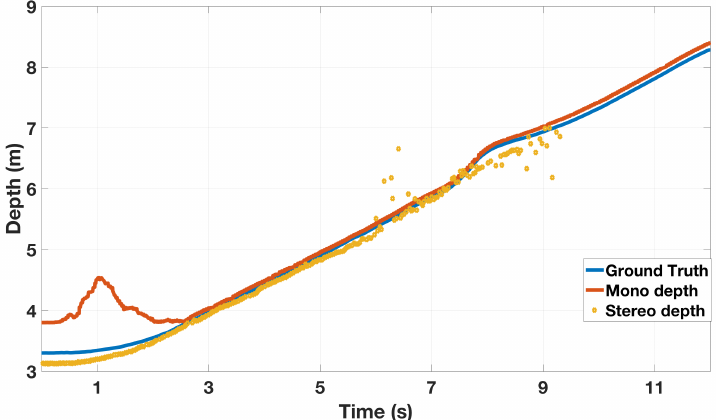
Figure 7. Depth estimation results for the stereo vision (amber) and motion parallax (red) approaches in the case of a peripheral point feature when the LOS angle is between 15 and 41 ◦ . The ground truth is shown by the blue line. The camera resolution is set to